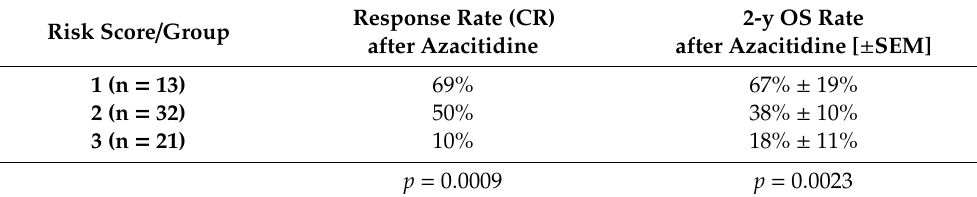
Table 5. Two-year overall survival and response rates of 66 patients with MDS and sAML with 20–29% BM blasts treated with azacitidine ± DLI for relapse after allo-HSCT according to the proposed scoring system. Response Rate (CR) 2-y OS Rate Risk Score / Group after Azacitidine after Azacitidine [ ± SEM] 1 (n = 13) 69% 67% ± 19% 2 (n = 32) 50% 38% ± 10% 3 (n = 21) 10% 18% ± 11% p = 0.0009 p =